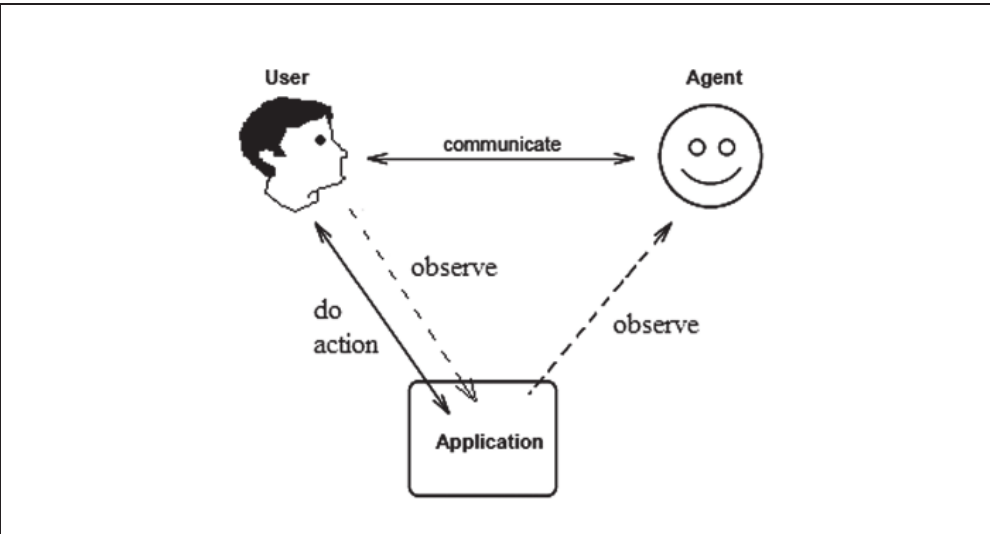
Figure 1 Collaborative interface agent for